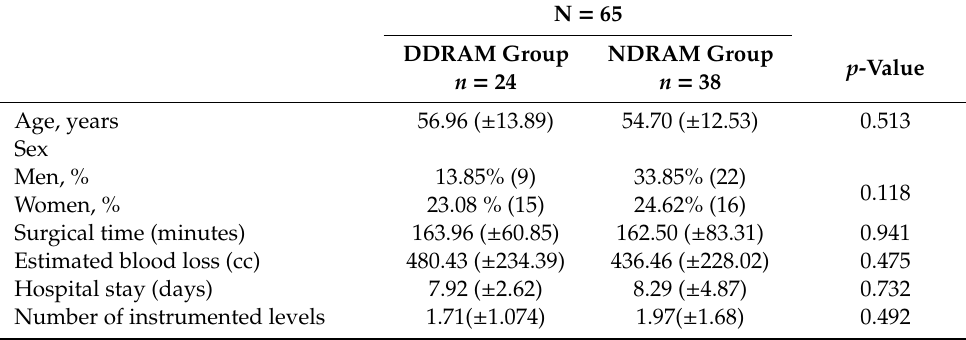
Table 2. Baseline demographic and clinical characteristics of patients included in the study stratified by DRAM score.